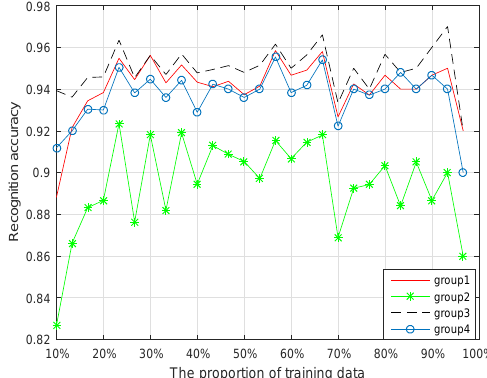
Figure 4. Average classification recognition accuracy in four cases.